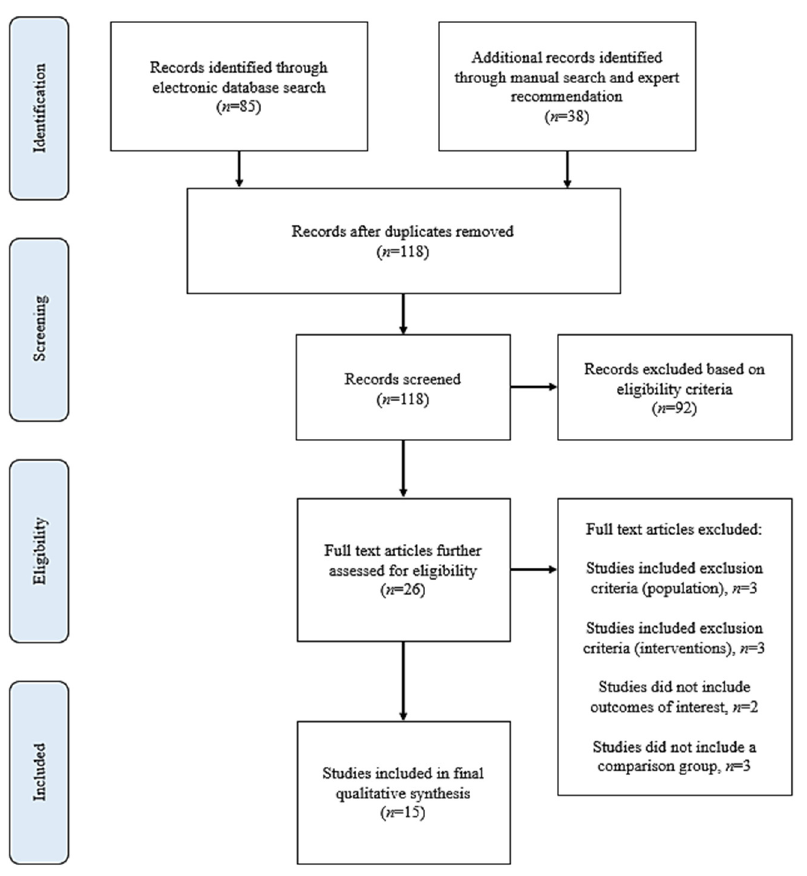
Figure 1. Flow diagram showing selection of studies for this review of early incorporation of nutrition interventions as a component of cancer therapy.